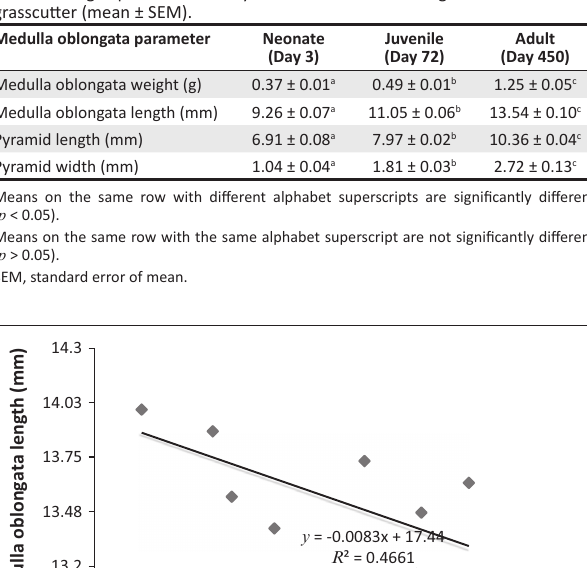
y = -0.0083x + 17.44 R ² =